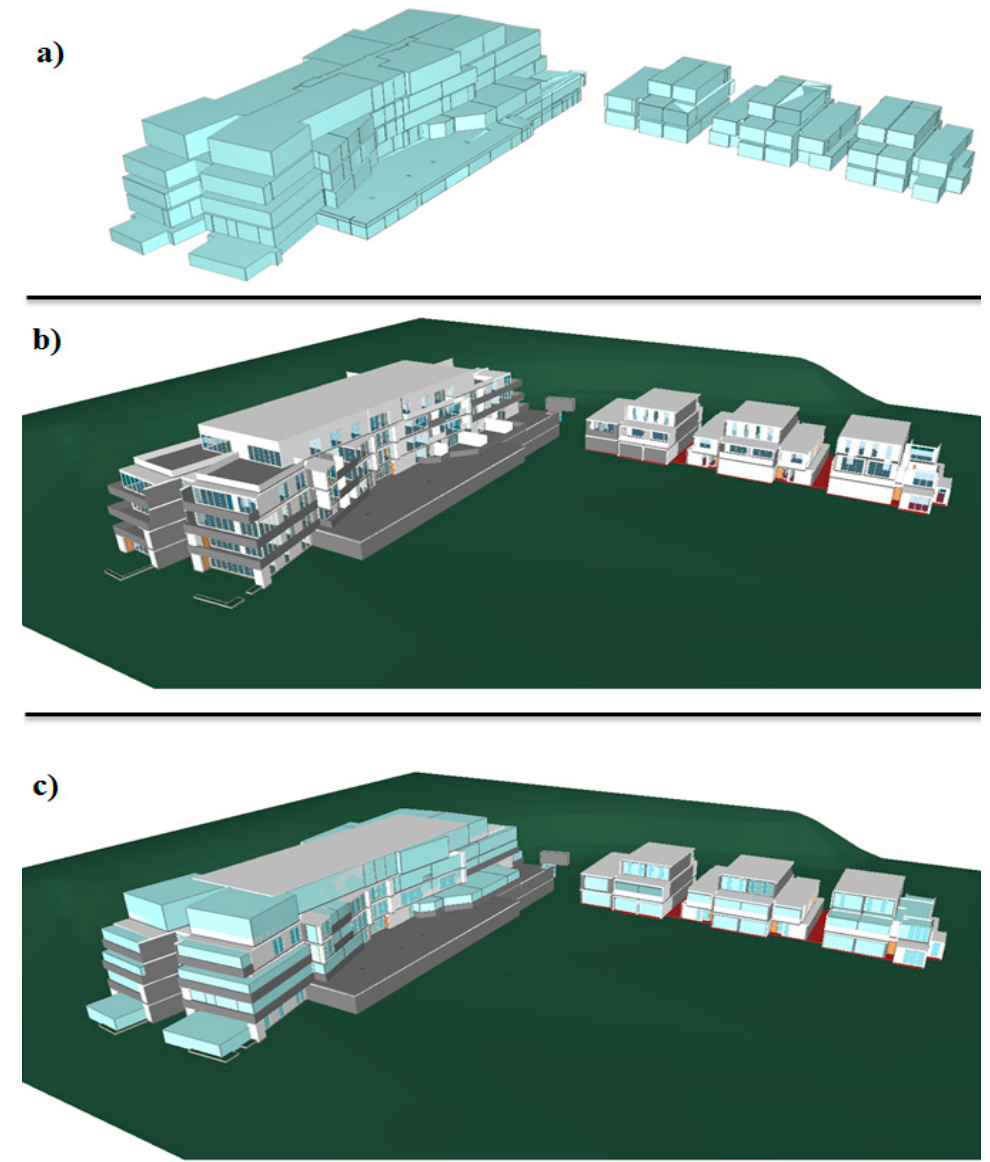
Figure 8. Implemented BIM models: ( a ) Purely legal model; ( b ) Purely physical model; ( c )